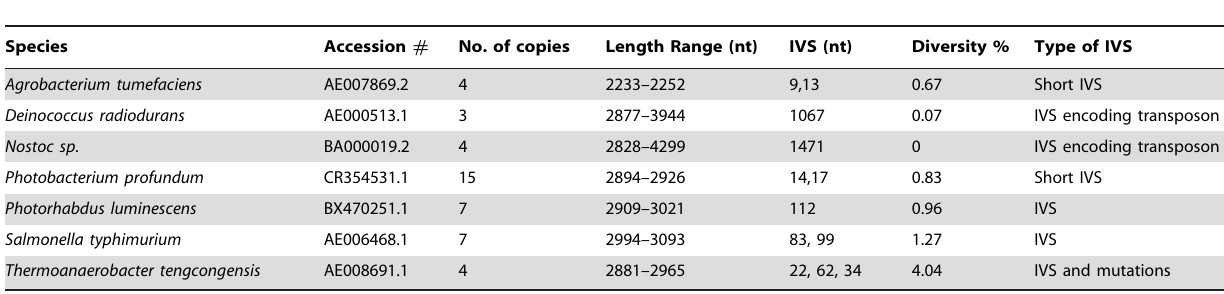
Table 3. Genomes with intervening sequences in 23S rRNA genes.